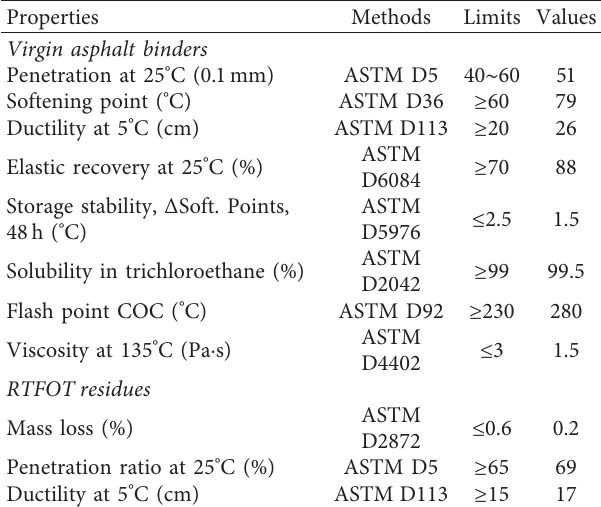
Table 1: The basic properties of SBS-modified asphalt binders.